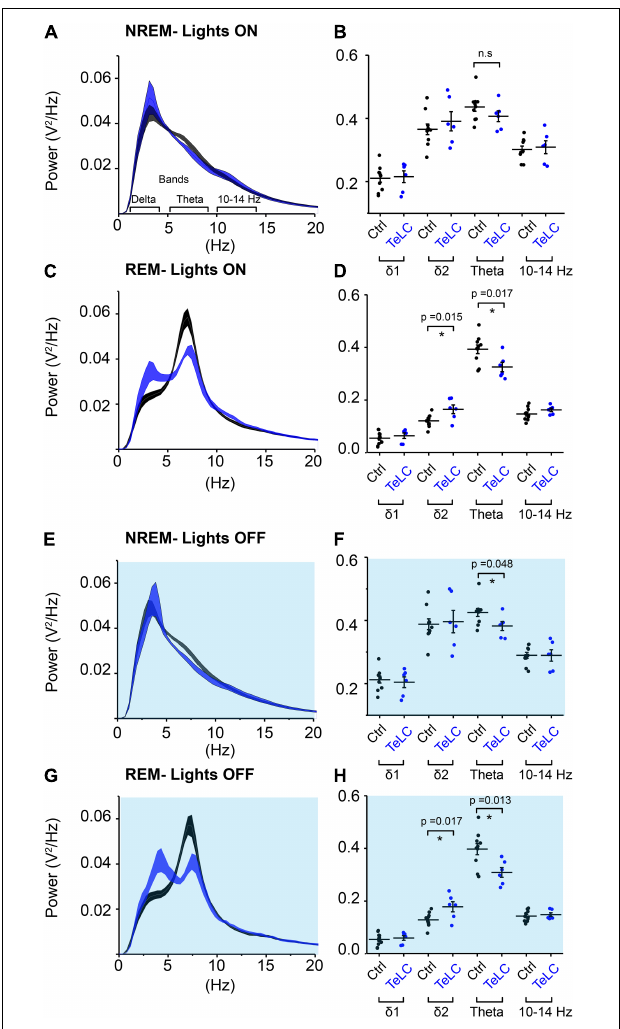
FIGURE 5 | NOS1 neurons in MnPO/MPO contribute to theta power during REM sleep. (A) Normalized power for NREM during the light period shown as a power spectrum. Different frequency bands are also illustrated. (B) For NREM during the light period, data for individual mice are shown for relevant frequency bands. (C) REM during the light period. (D) Quantification of spectral differences during REM in the light period for individual mice show more δ 2 in the TeLC condition ( t test, n = 6, TeLC; n = 10, GFP; p = 0.015) alongside reduced theta ( t test, n = 6, TeLC; n = 10, GFP; p = 0.017). (E) Normalized power for NREM in the dark period shown as a power spectrum. (F) Data for individual mice are shown for relevant frequency bands ( t test, n = 6, TeLC; n = 10, GFP; p = 0.048). (G) REM during the dark period. (H) Quantification of spectral differences during REM in the light period for individual mice ( δ 2 between groups, t test, n = 6, TeLC; n = 10, GFP; p = 0.017). Theta between groups ( t test, n = 6, TeLC; n = 10, GFP; p = 0.013). Multiple comparisons were accounted for using the Benjamini-Hochberg procedure at a false discovery rate of 5%. * P < 0.05, n.s, not